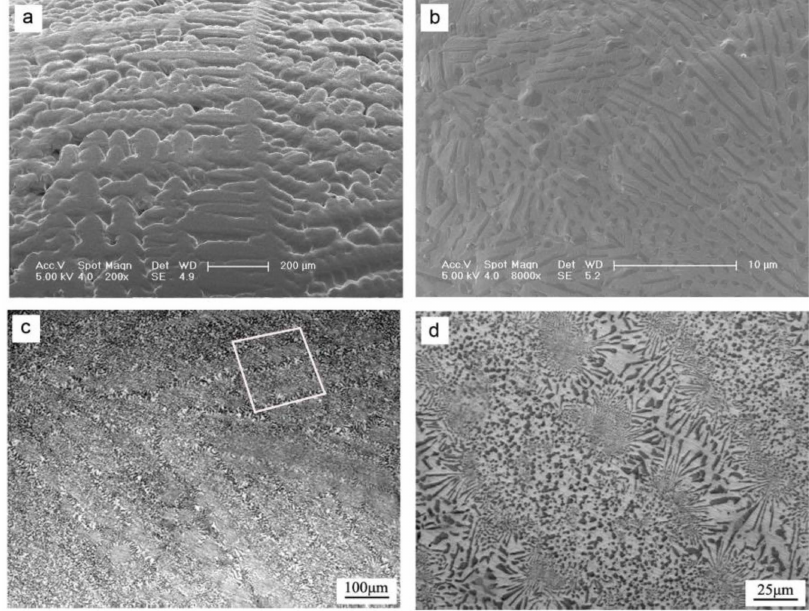
Figure 5. Microstructures of (Ag-28.1Cu)-0.5Sb alloy undercooled by 85 K, ( a ) the surface structure with dendritic morphology at low magnification, ( b ) lamellar eutectics in the surface dendrite arms at high magnification, ( c ) the internal structure with dendritic morphology at low magnification, and ( d ) anomalous eutectics and the lamellar eutectics around them in the quadrilateral region at high magnification.